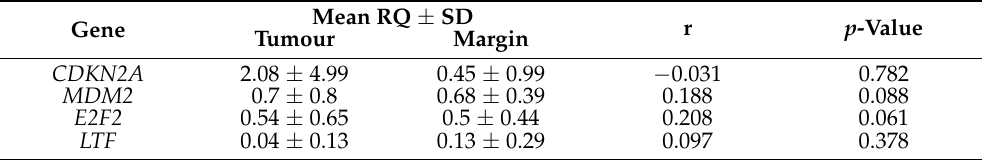
Table 2. Relative quantification (RQ) values for CDKN2A , MDM2 , E2F2 and LTF genes in tumour vs. margin in patients with OSCC (Spearman’s rank correlation coefficients r, p -Value).